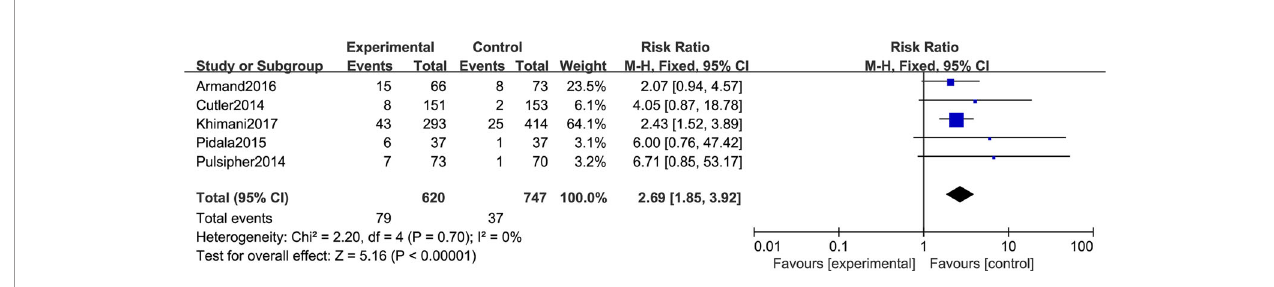
FIGURE 6 | The effect of SRL-based and non-SRL-based prophylaxis on